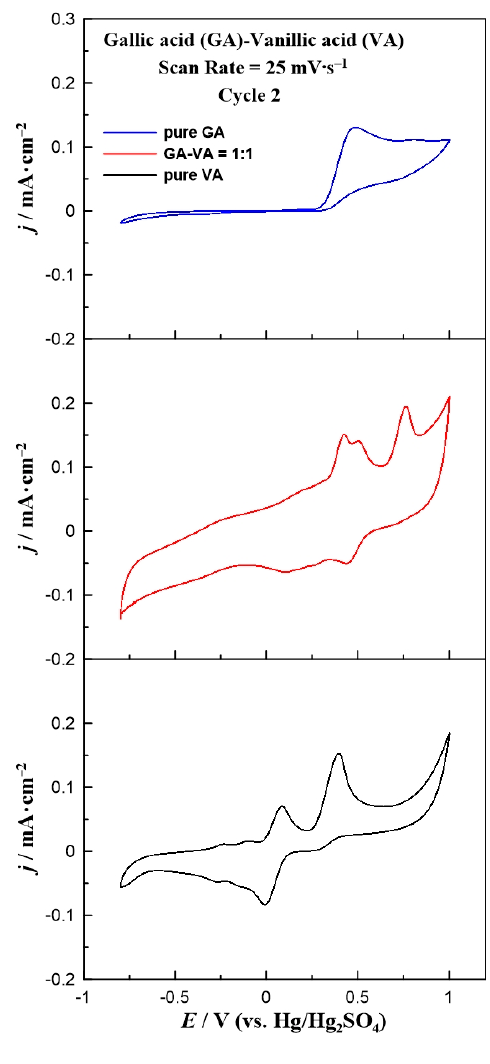
Figure 7. Comparison of the cyclic voltammograms for pure gallic acid, pure vanillic acid, and a 1:1 mixture of them at a constant scan rate of 25 mV ∙ s − 1 .